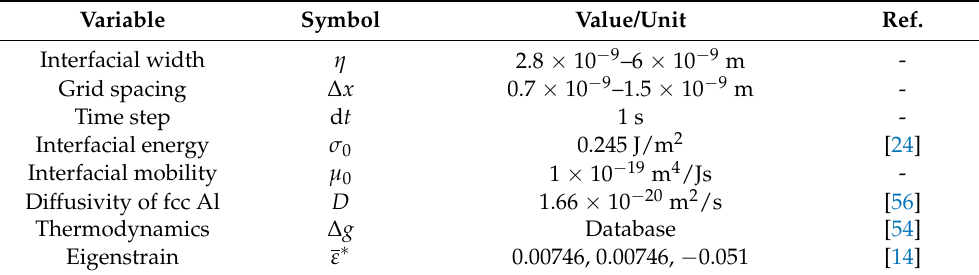
Table 2. Summary of the parameters in the present phase-field